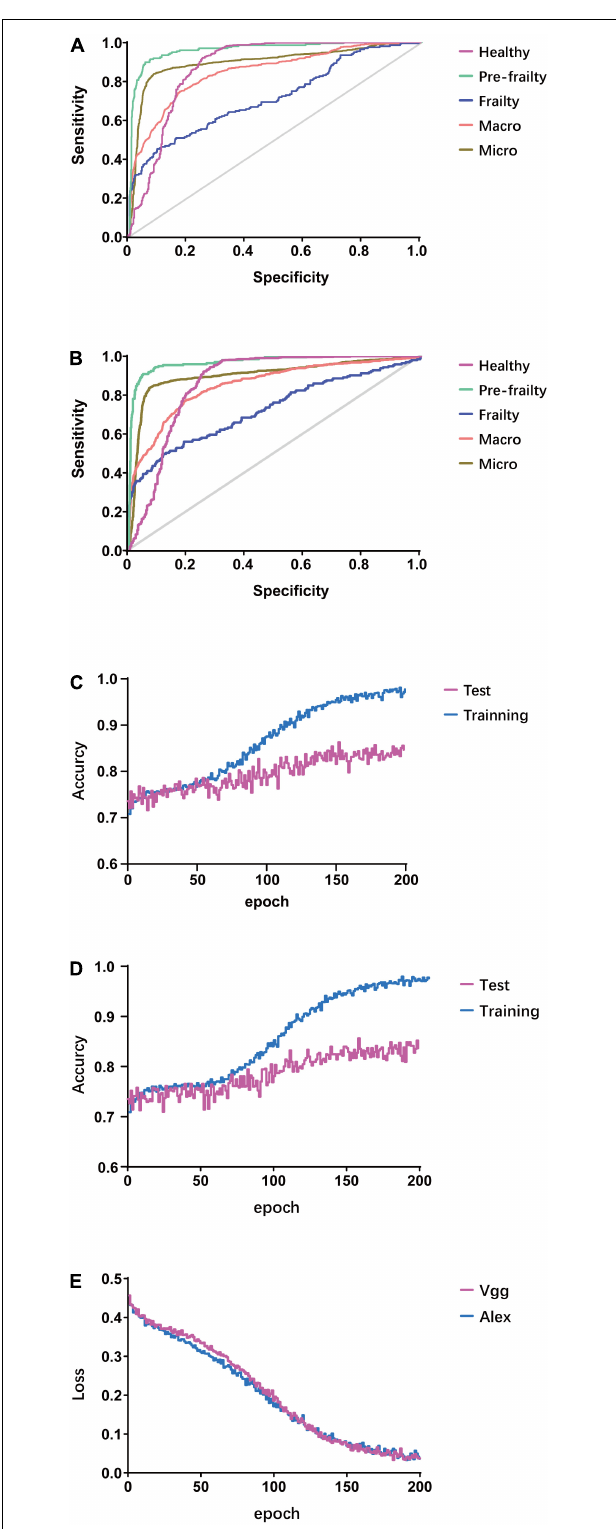
FIGURE 6 | Results of gait feature classification. (A) ROCAUC of validation set via AlexNet. (B) ROCAUC of validation set via VGG. (C) Accuracy via AlexNet. (D) Accuracy via VGG16. (E) Loss function of training